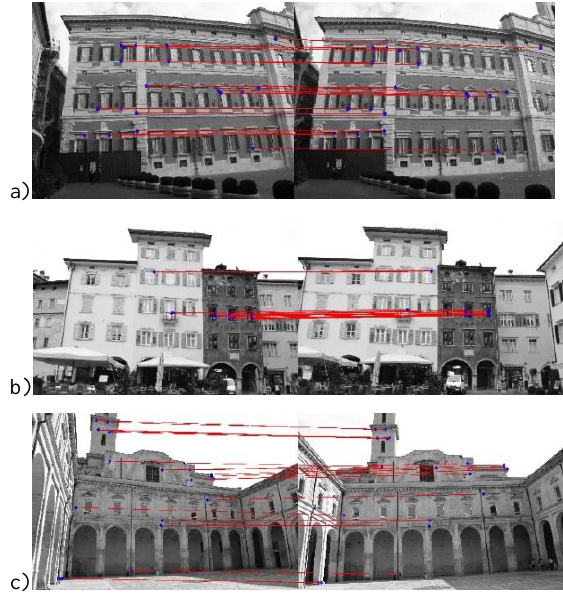
Figure 6: Constrained feature matching for tie points extraction based on the feature’s label. For a clearer visualisation, only few features are drawn on grey scale